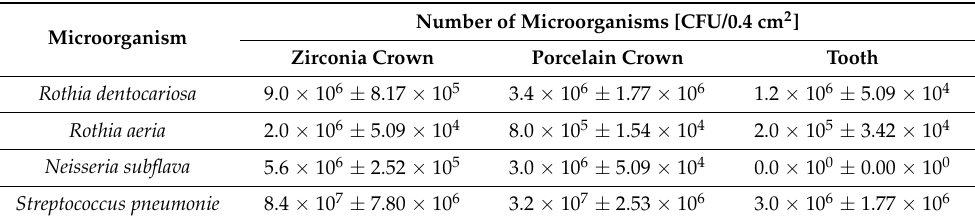
Table 2. The average number of the most abundant species of microorganisms on the surfaces of individual materials identified by the MALDI-TOF